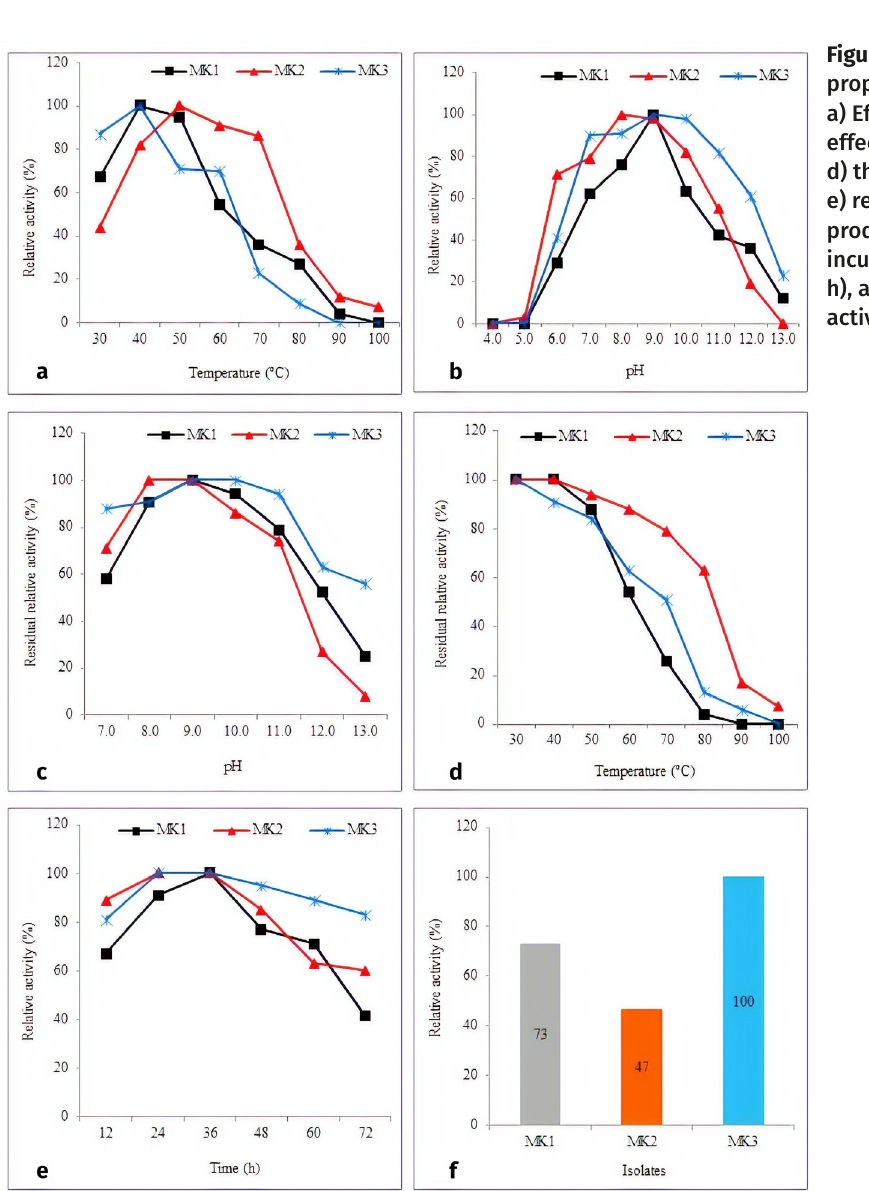
Figure 6. Enzymatic properties of